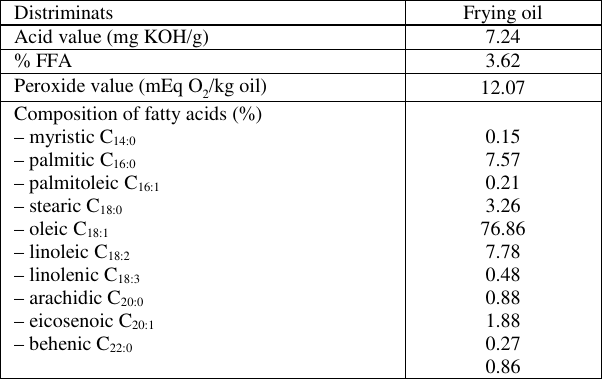
Table 1. Characterization of the frying oil Distriminats